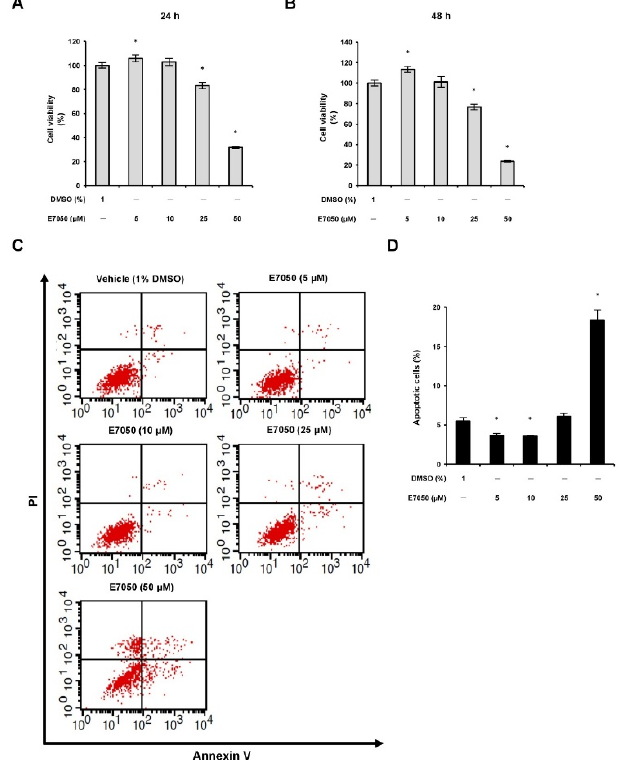
Figure 1. Effects of E7050 on cell viability and cell death in multidrug-resistant human uterine sarcoma MES-SA/Dx5 cells. Cells were exposed to different concentrations (5, 10, 25 and 50 µ M) of E7050 for ( A ) 24 h or ( B ) 48 h, and cell viability was analyzed using the MTT assay. ( C ) Cells were treated with the indicated concentrations of E7050 for 24 h and stained with Annexin V ‐ FITC and